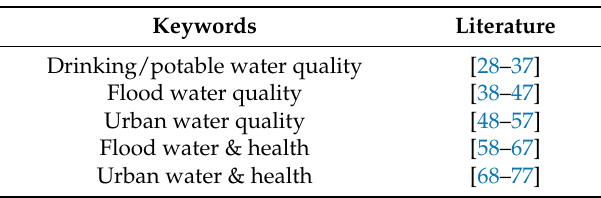
Table 1. Select literature based on keyword